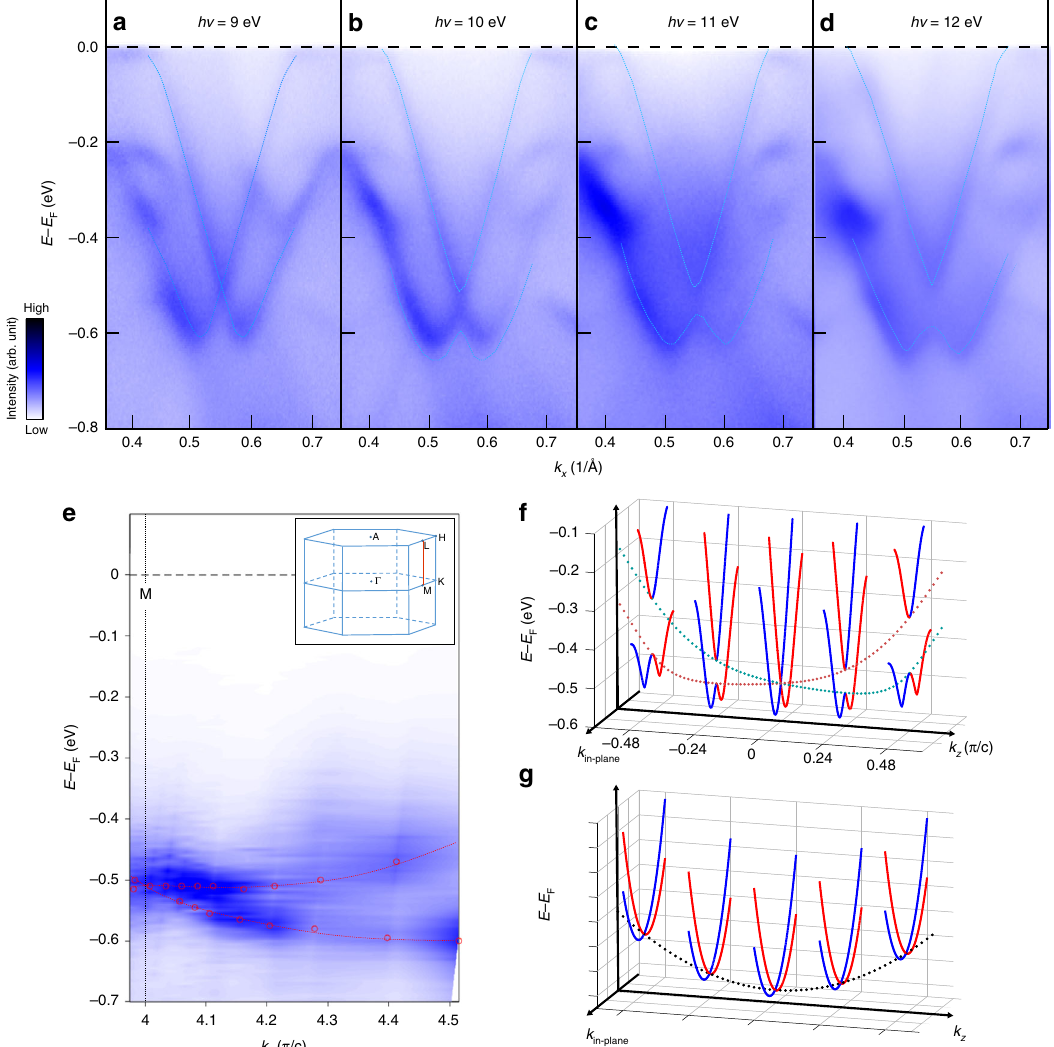
Fig. 5 Three-dimensional nature of Rashba-like bands around M point. a – d Energy – momentum image mapped by angle-resolved photoemission spectroscopy (ARPES) taken at different photon energies. e Band dispersion along M – L direction obtained by plotting energy distribution curves at the M point taken at different photon energies as function of k z (the M – L direction as sketched in the three-dimensional Brillouin zone shown in the inset). f Calculated band structure of PtBi 2 along the in-plane and out-of-plane momentum directions. The red and blue solid lines show the in-plane band structures at different k z . The red and green dashed lines show the band dispersions along k z direction, indicating Rashba splitting along k z . g Sketch of Rashba bands which have dispersion along k z but remain spin degenerate along k z for k x = k y =